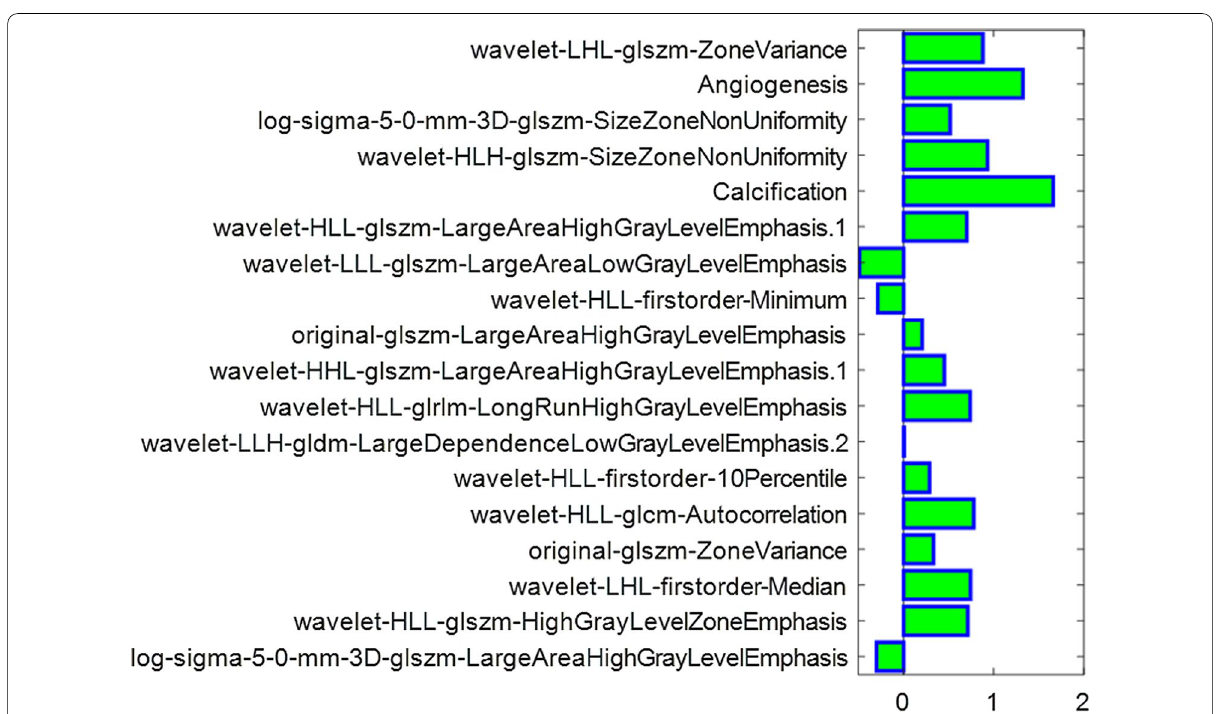
Fig. 3 Diagram of the feature selection result. The bar plot represents the weight of each feature in the support vector machine